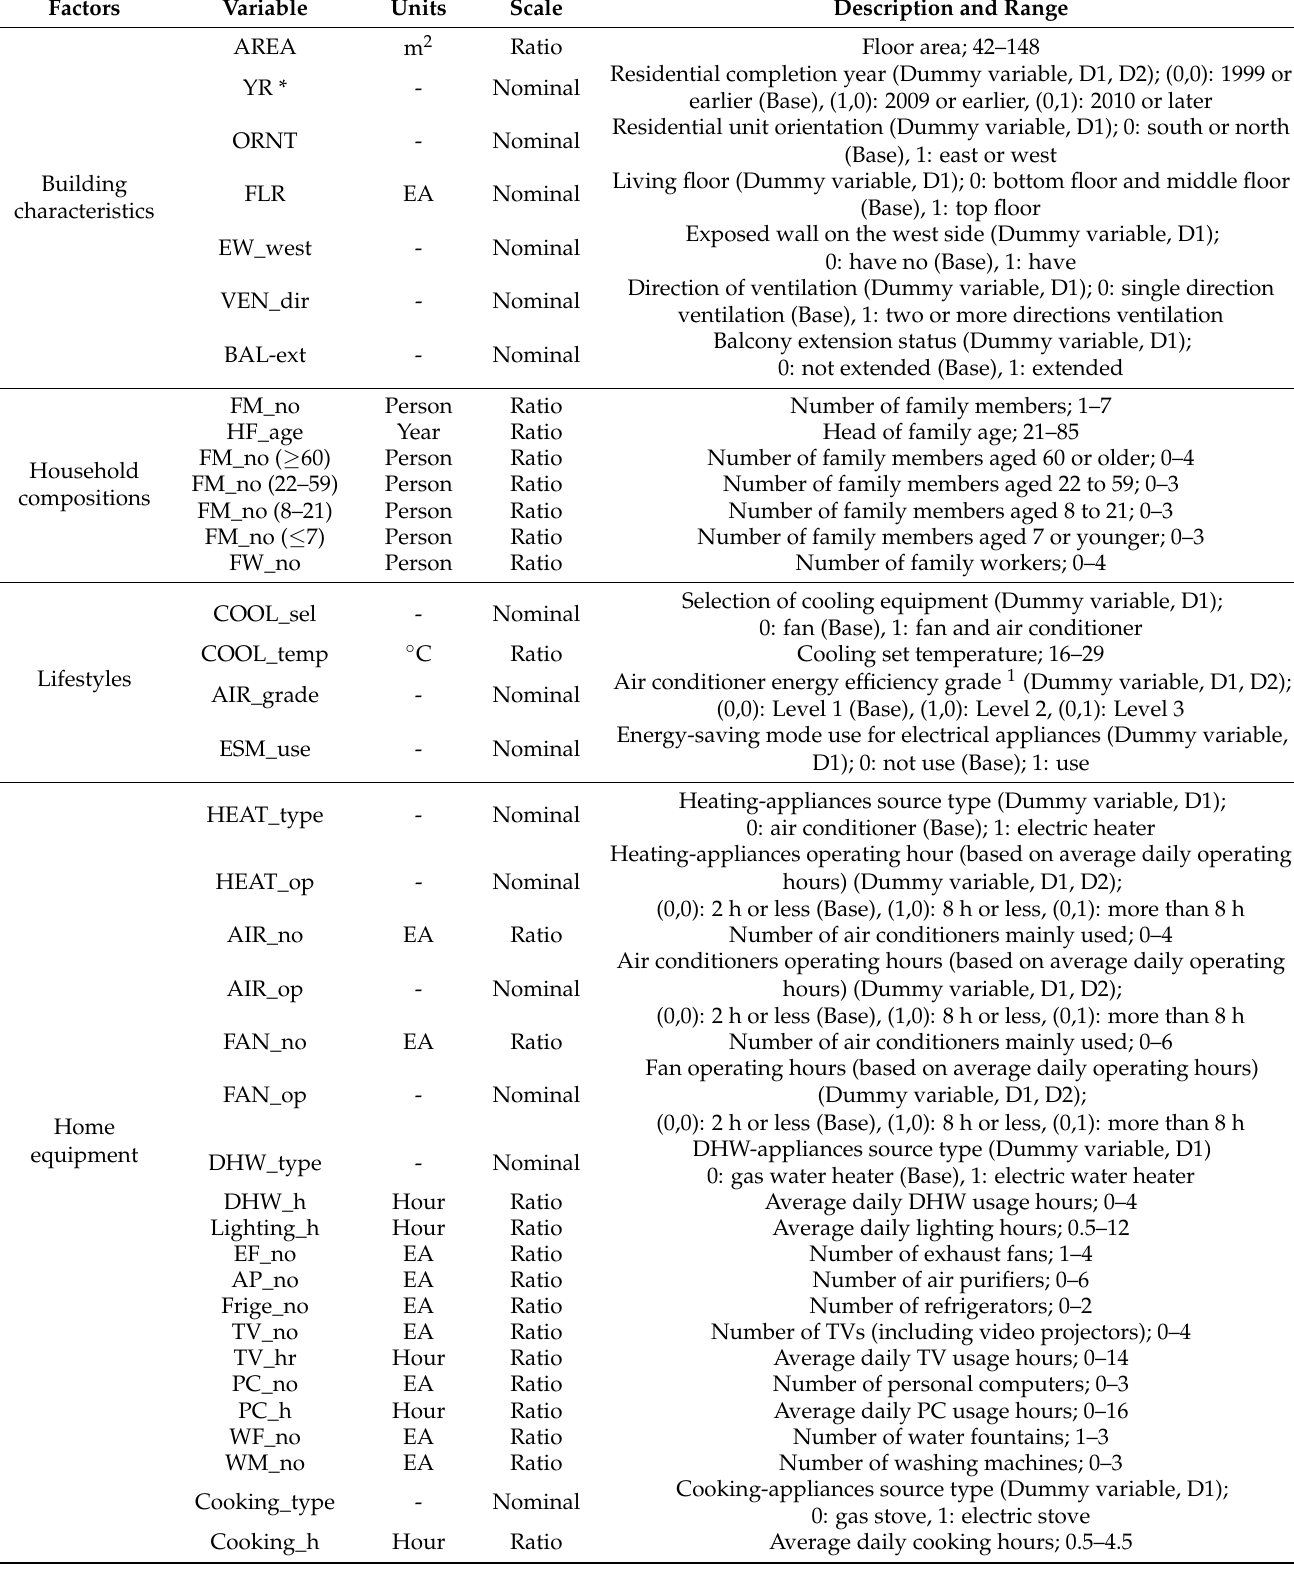
Table 2. Details of independent